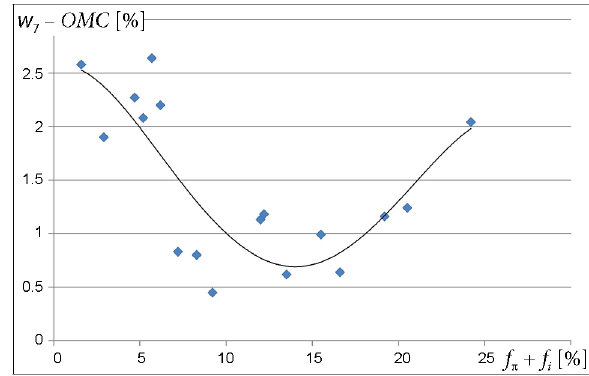
Figure 8. Increase of the moisture content as a function of the fine fraction